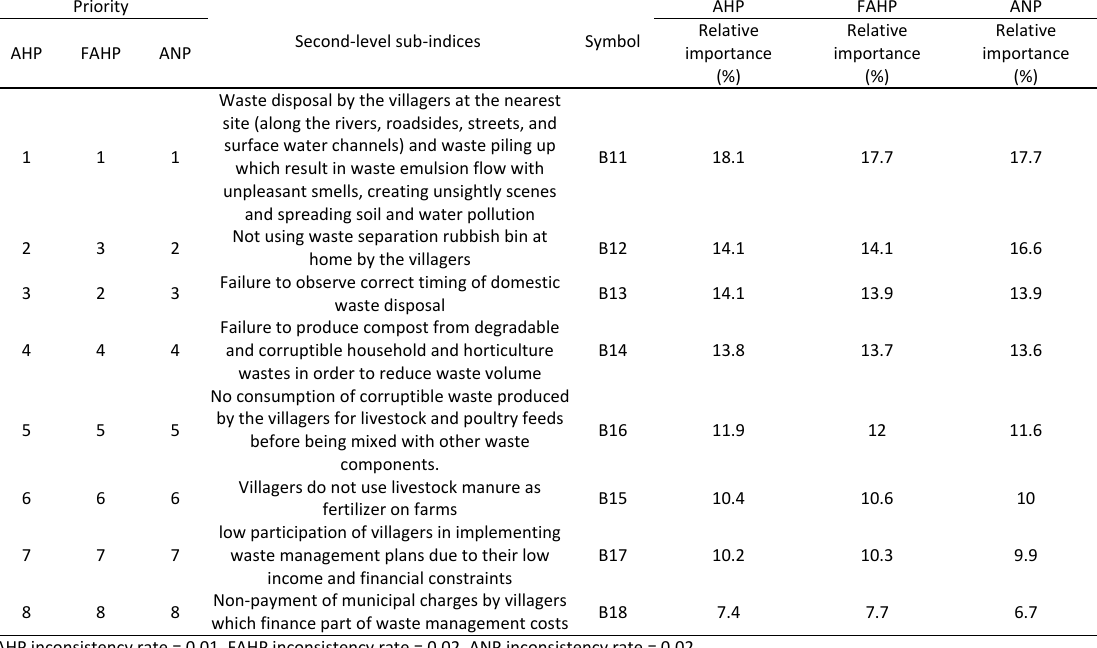
Table 4: Prioritization of weaknesses and relative importance values of the sub-indices of the B1 index based on AHP, FAHP, and ANP